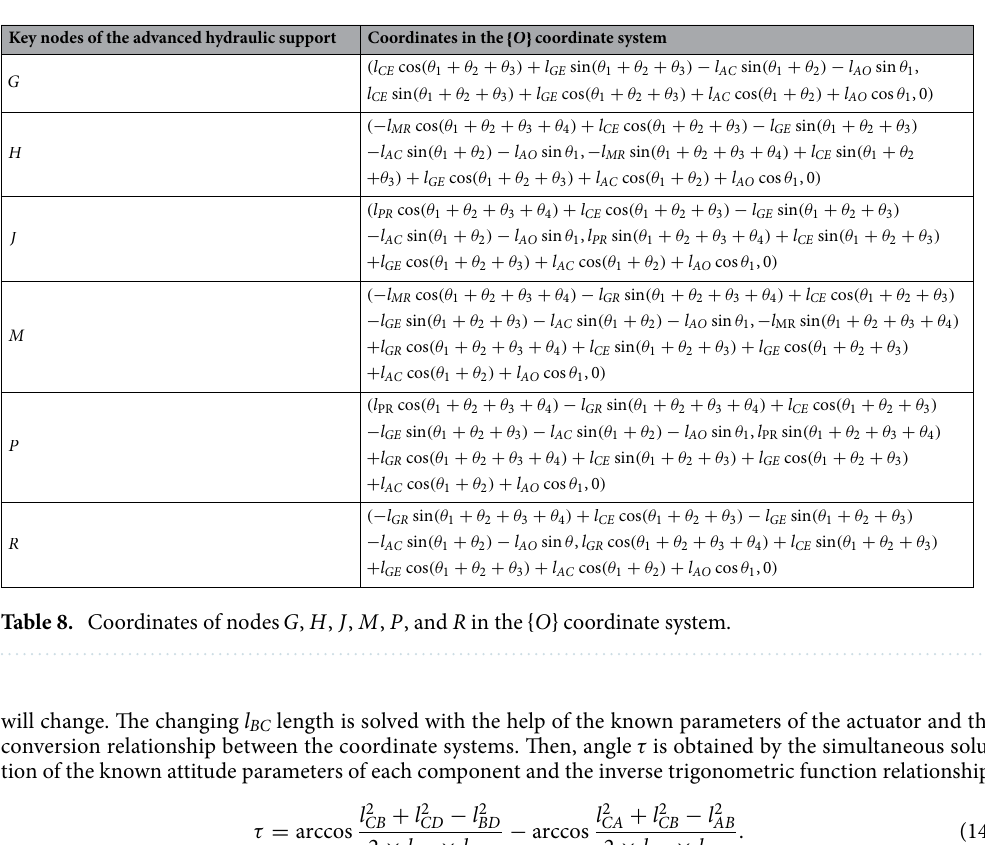
Key nodes of the advanced hydraulic